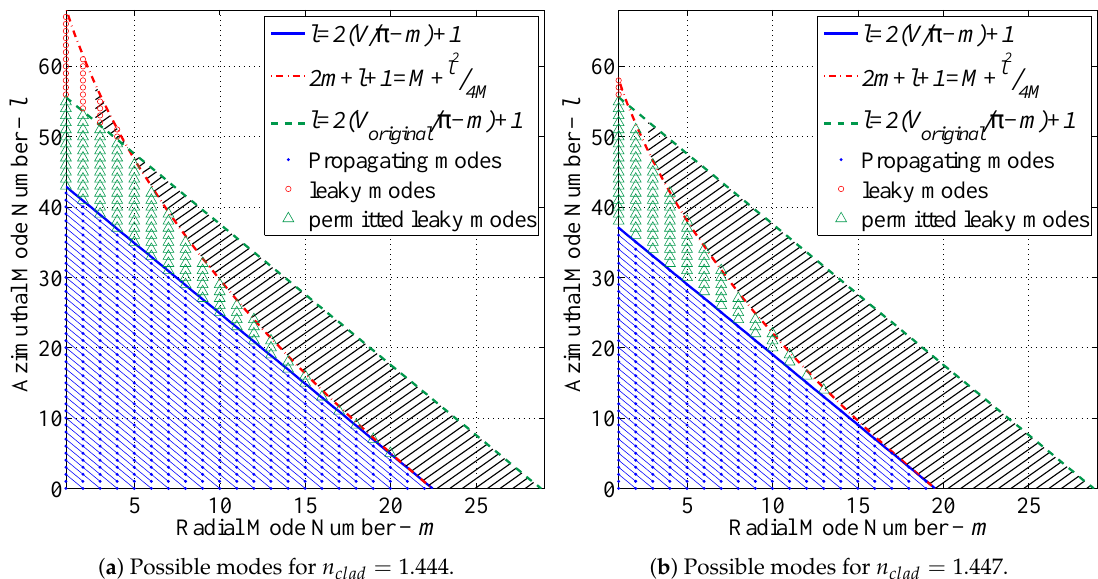
Figure 11. Comparison of permissible guided and leaky mode sets for ( a ) 40% of the total RI range ( b ) 60% of the total RI range.